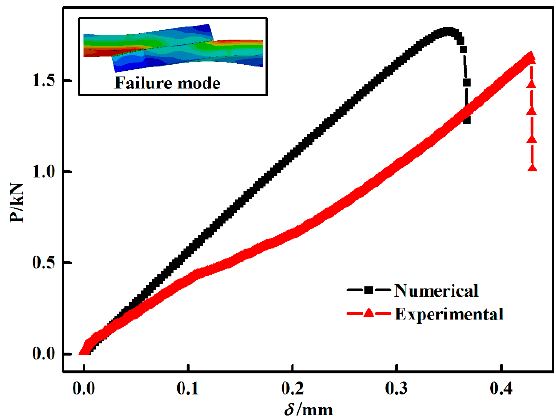
Figure 9. Comparison of P − δ curves for curing temperature curve (CT)-1 between the simulation and experiment.